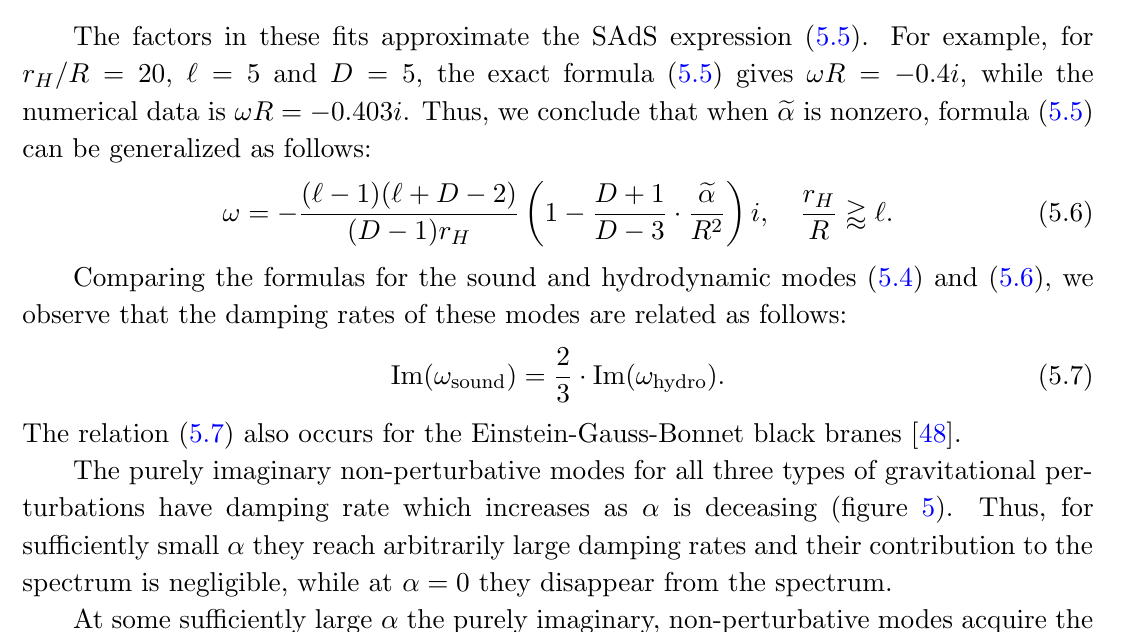
Figure 5 . Purely imaginary non-perturbative in of (cid:11) for ‘ =